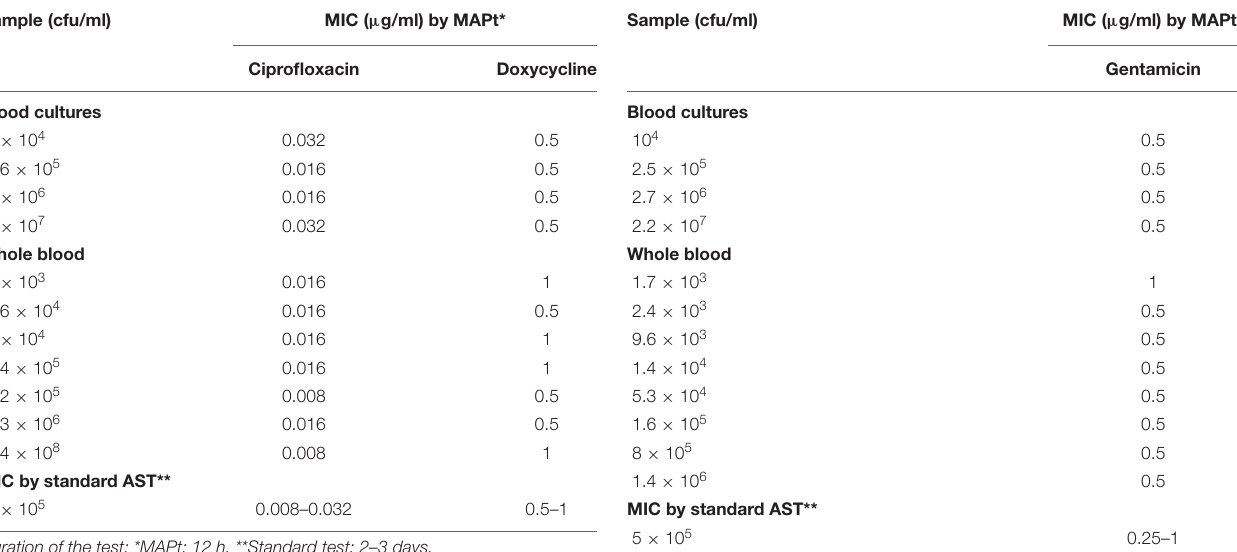
TABLE 3 | MIC values obtained by MAPt of blood cultures and whole blood samples inoculated with Y. pestis . Sample (cfu/ml) MIC ( µ g/ml) by MAPt*